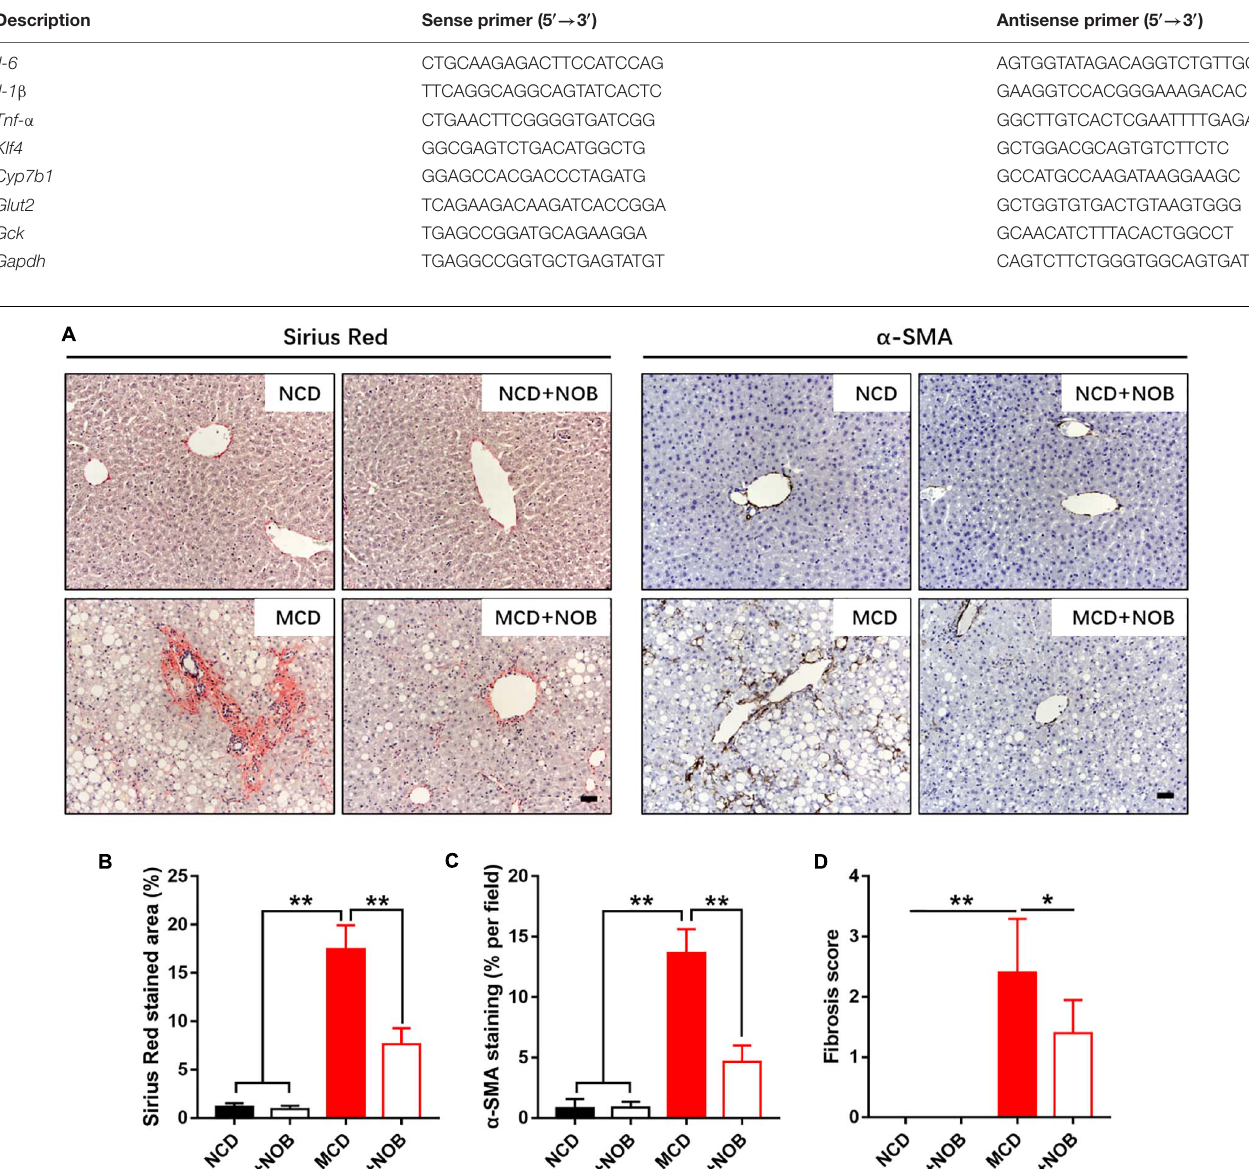
in inflammatory responses (Wan et al., 2014; Kong et al.,